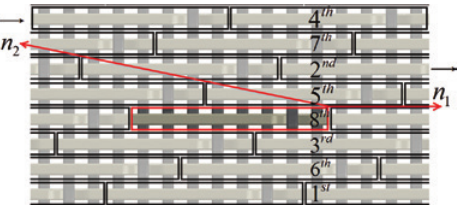
Figure 3: Repeating direction of periodic cell of weave composites (with matrix and Z tows